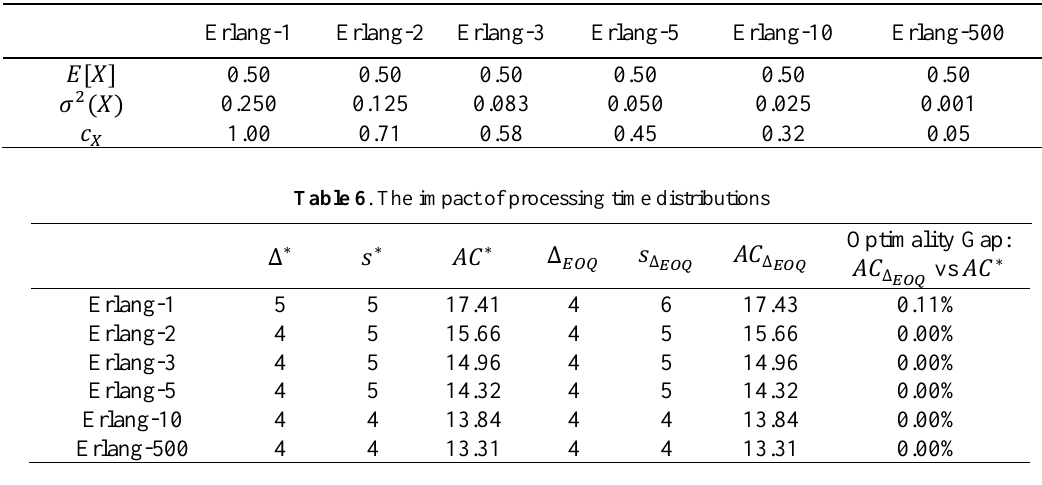
Table 5. Processing time distributions with the corresponding parameter values